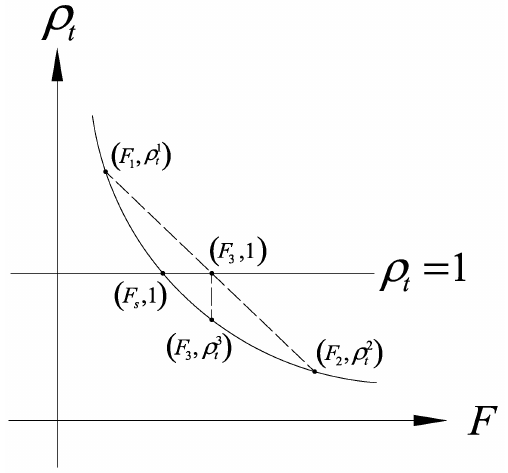
Figure 3. Secant method for factor of safety.